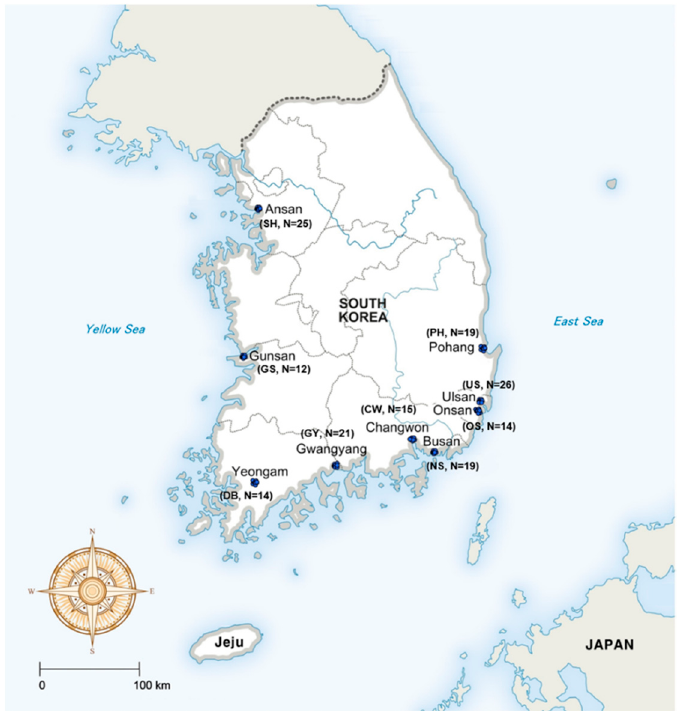
Figure 1. Map of the study area showing road dust sampling locations from 9 different industrial areas of Korea. Table 1. Information on the number of operating facilities, designated area (km 2 ), the number of employees, residents and major industrial types in different industrial regions collected from the road dust (RD) of this study.